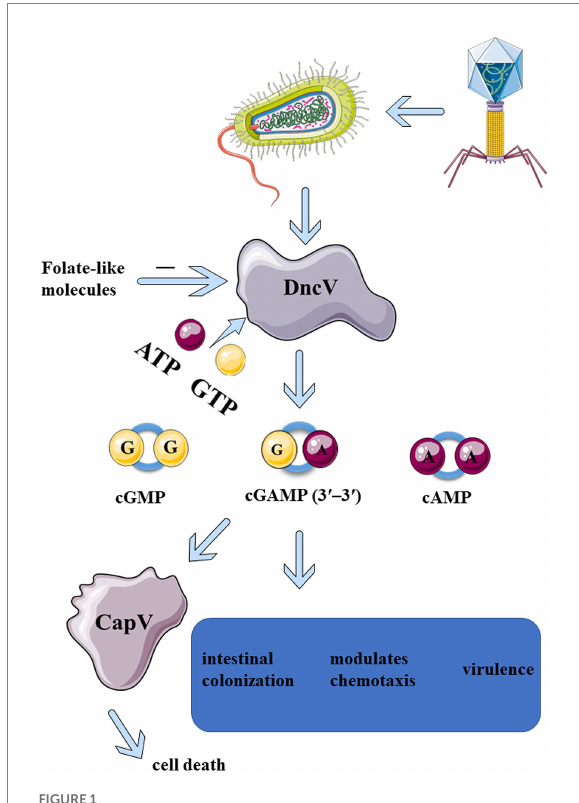
FIGURE 1 Upon infection of phages, DncV is induced and activated in Bacteria , which in turn recruits ATP and GTP to produce CDNs, mainly 3 ′ 3 ′ -cGAMP. 3 ′ 3 ′ -cGAMP can activate CapV phospholipase, leading to bacterial cell membrane degradation and bacterial death before phage replication is complete. 3 ′ 3 ′ -cGAMP is essential for regulating the chemotaxis, virulence, and colonization of Vibrio cholerae and other bacteria (Davies et al., 2012). The enzymatic activity of DncV is inhibited by folate- like molecules, which might be the negative feedback mechanism that folate-like metabolism cofactors modulate the synthesis of cyclic dinucleotide second